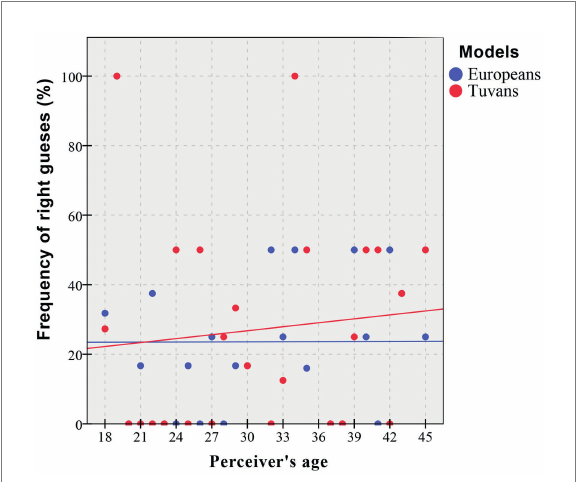
FIGURE 2 Impact of perceivers’ age on fear recognition in models of European and Tuvan